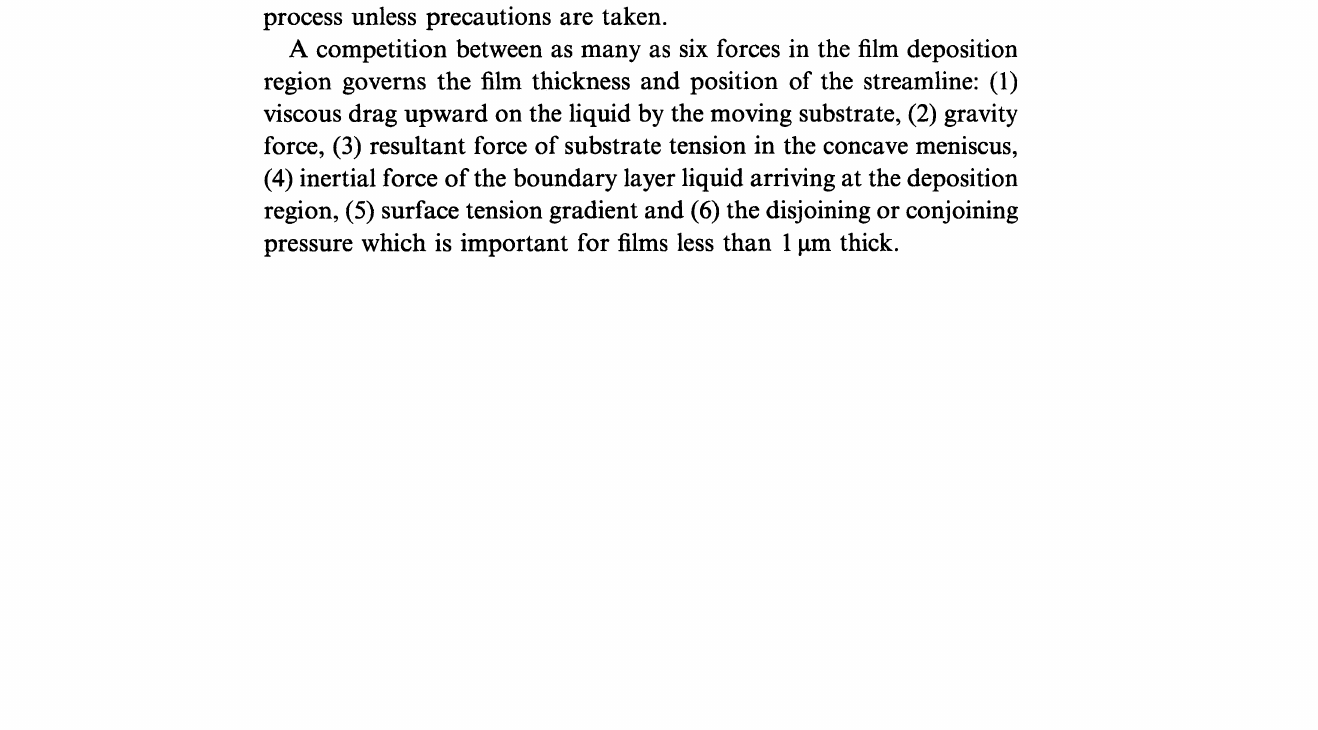
FIGURE Basic design of electrochromic device, indicating transport of the positive ions M + under the action of an electric field. TE standsfor ’Transparent Electrode’, EC for ’Electrochromic Material’, IS for ’Ion (M +) Storage’ material which can also be an electrochromic